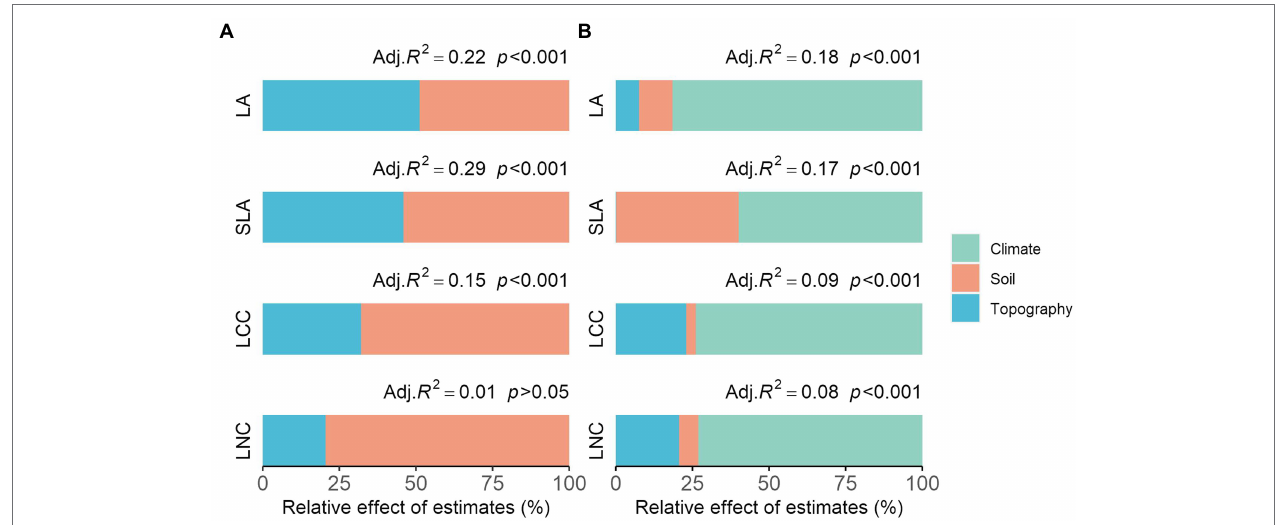
FIGURE 3 | The relative importance of each environmental factor on community functional composition across the (A) local scale and (B) regional scale, expressed as the percentage of explained variance. We showed the adjusted R 2 and the value of p of the averaged models. LA, leaf area; LCC, leaf carbon content; LNC, leaf nitrogen content; SLA, specific leaf